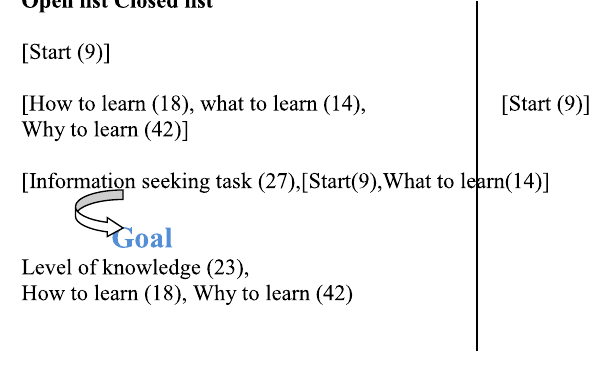
Table 3 The estimated cost of each component Personalization parameters Heuristics Personalization parameters (start) 9 Why to learn? How to